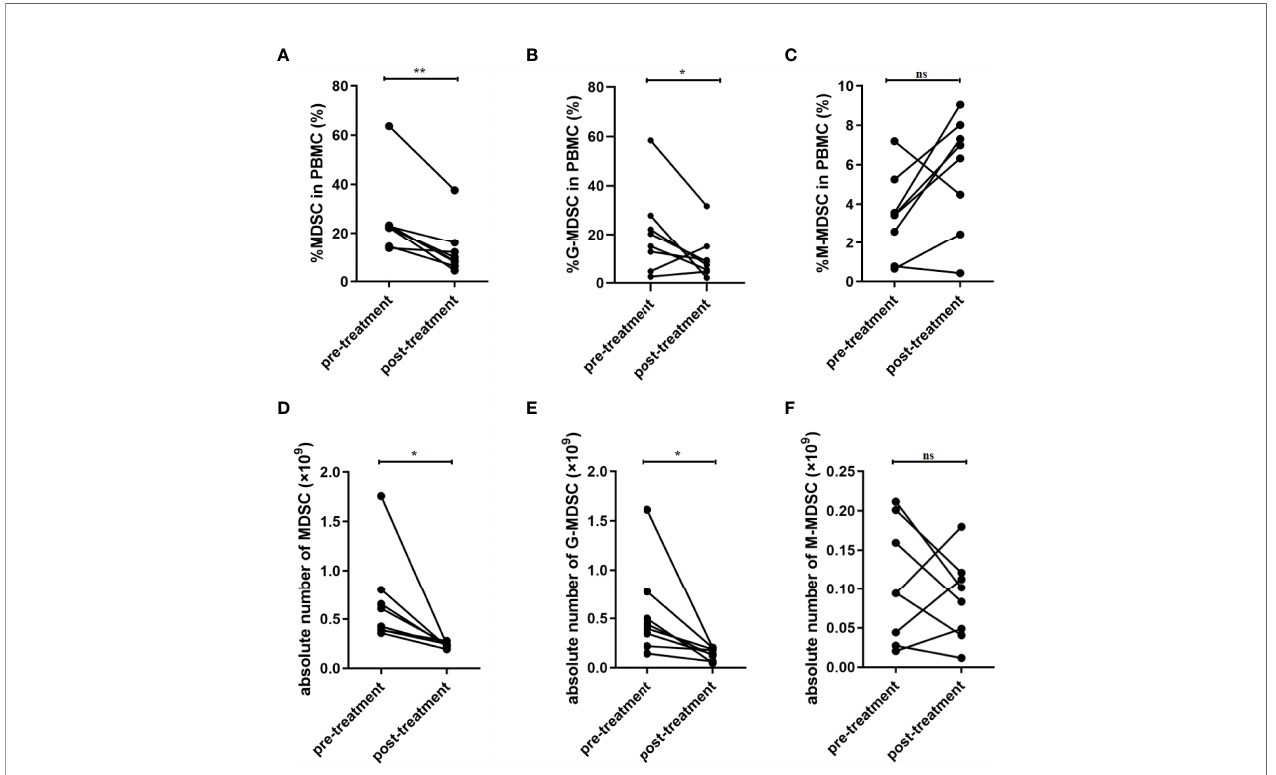
FIGURE 2 | Frequency of MDSCs was decreased after treatment in patients with SAP. (A) Percentage of MDSC in PBMC was decreased after treatment. Percentage of G-MDSC (B) and M-MDSC (C) in PBMC had no signi fi cant difference after treatment. The absolute number of MDSC (D) and G-MDSC (E) was decreased after treatment. (F) The absolute number of M-MDSCs had no signi fi cant difference after treatment. n = 8. PBMC, peripheral blood mononuclear cell. * p <0.05; ** p <0.01; ns, not signi fi